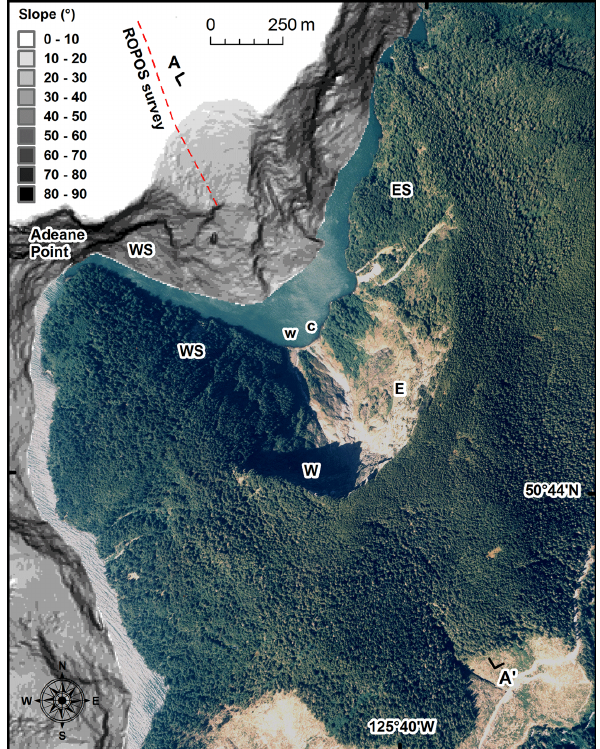
Figure 4. Vertical image showing the subaerial and submarine parts of the rock slope at Adeane Point. The offshore area is represented by a slope map generated from swath bathymetry. WS: west slope; W: west wall; w: west gully; c: central gully; E: east wall; ES: east